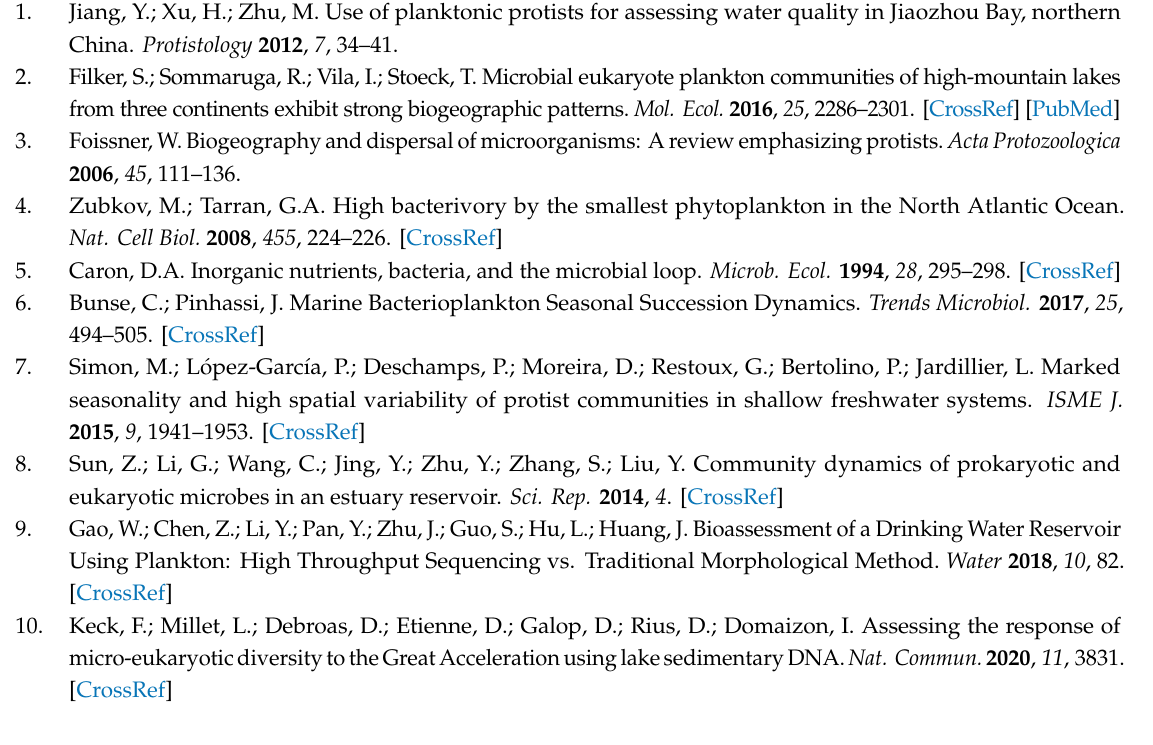
Table S1: The classification standards for lake water quality and water function in China